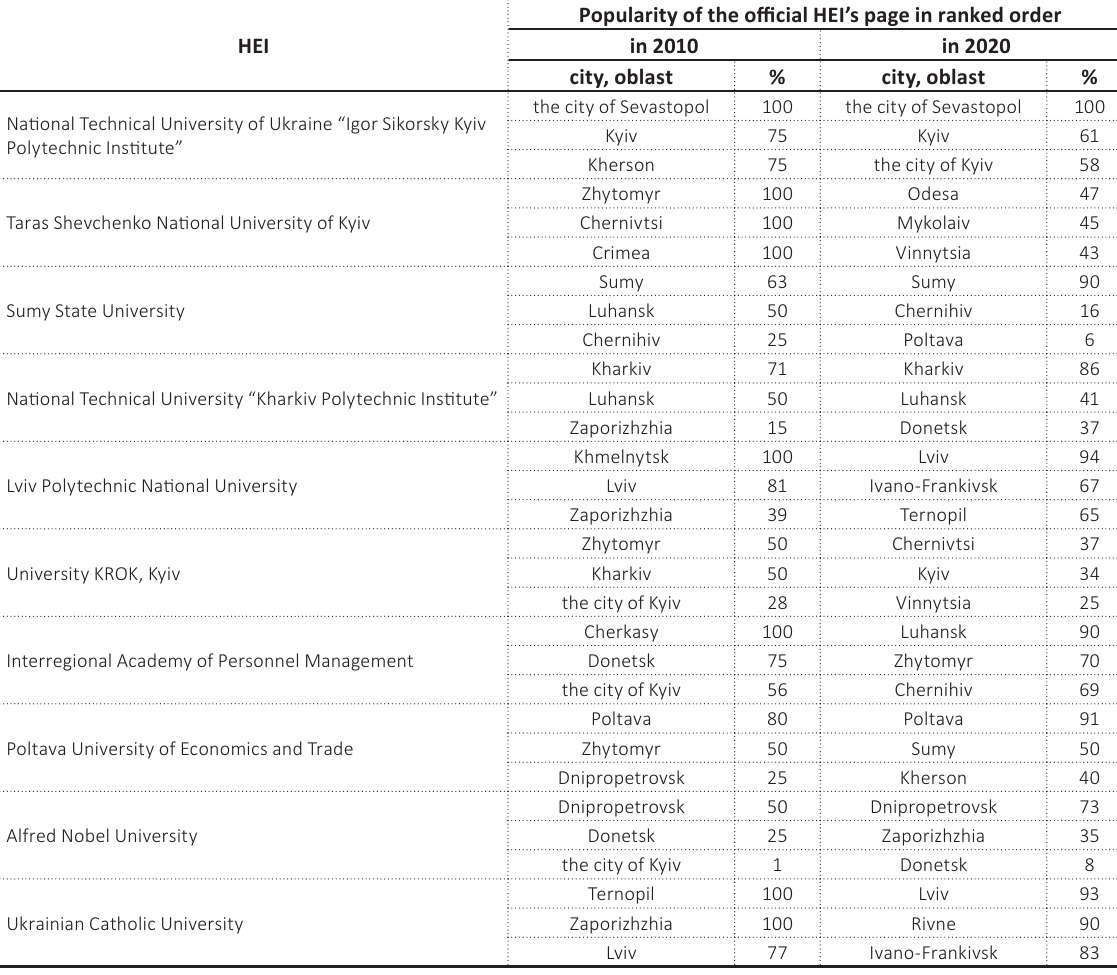
Table 4. Comparison of the number of queries in the Google search system by the official name of HEIs in the oblasts of Ukraine in 2010 and